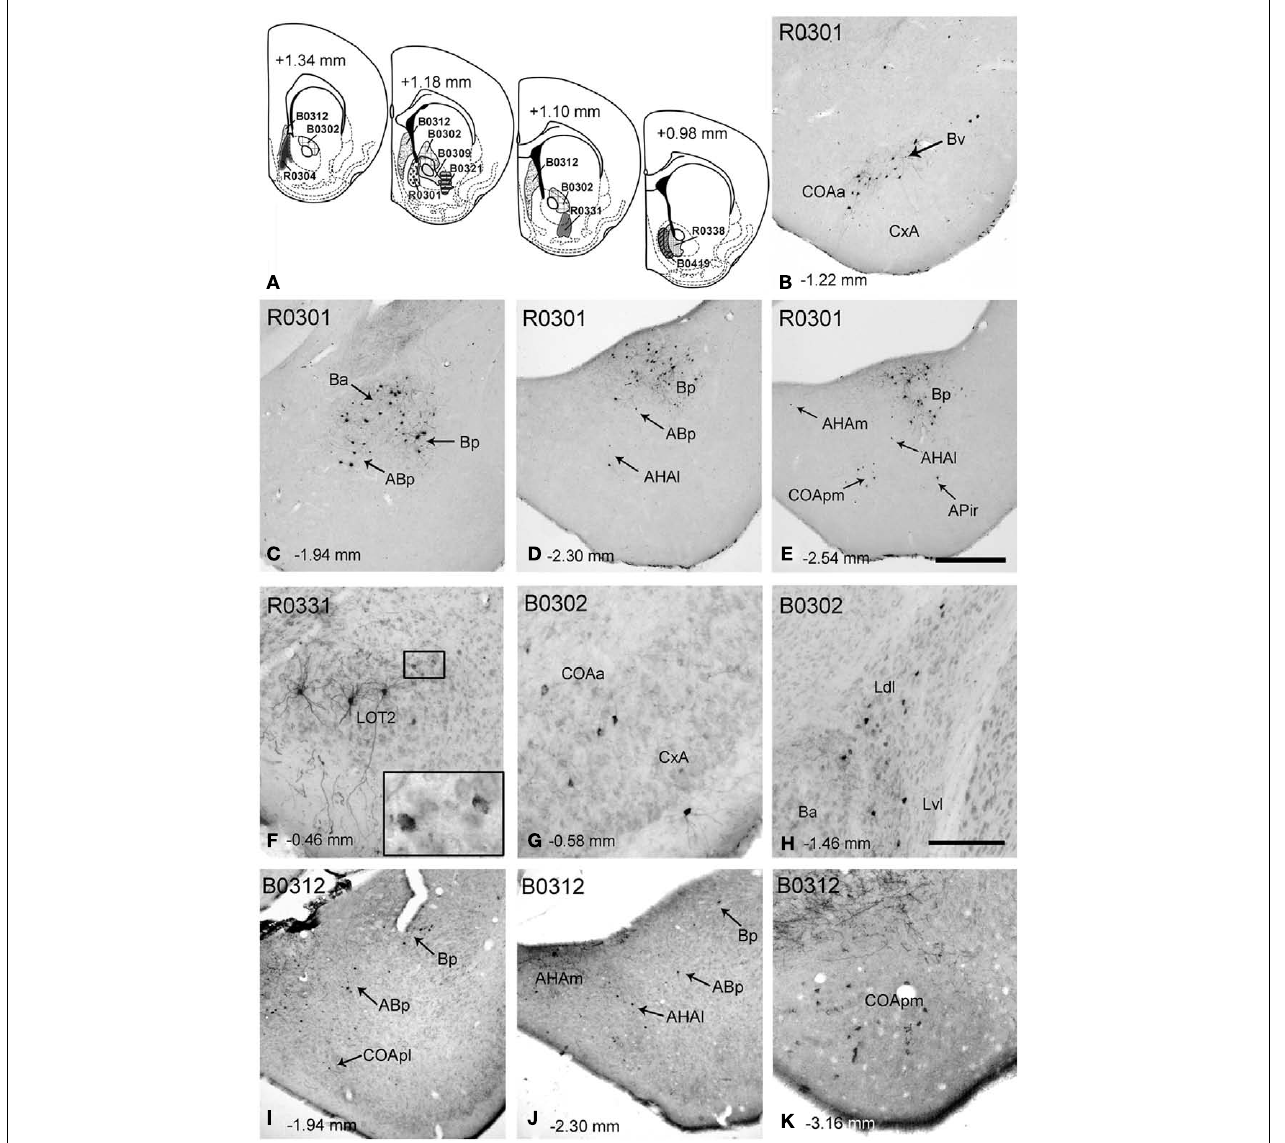
cortical nuclei both in the anterior (B,C) and posterior amygdala (D,E) . (F) Retrogradely labeled neurons in the LOT ipsilateral to a tracer injection in the LAcbSh (R0331). Golgi-like labeled cells are clearly visible in layer 2, but layer 3 also displays cells showing granular labeling (inset). (G,H) Retrograde labeling in different centers of the pallial amygdala, resulting from a BDA injection in the AcbC (B0302). (I–K) Retrogradely labeled neurons in the pallial amygdala after a BDA injection in the ventral septum that encompassed the major island of Calleja (B0312). For abbreviations, see list. Calibration bar in (E) = 400 μ m [also valid for (B–D,I,J) ]. Scale bar in (H) = 150 μ m [also valid for (F–K)